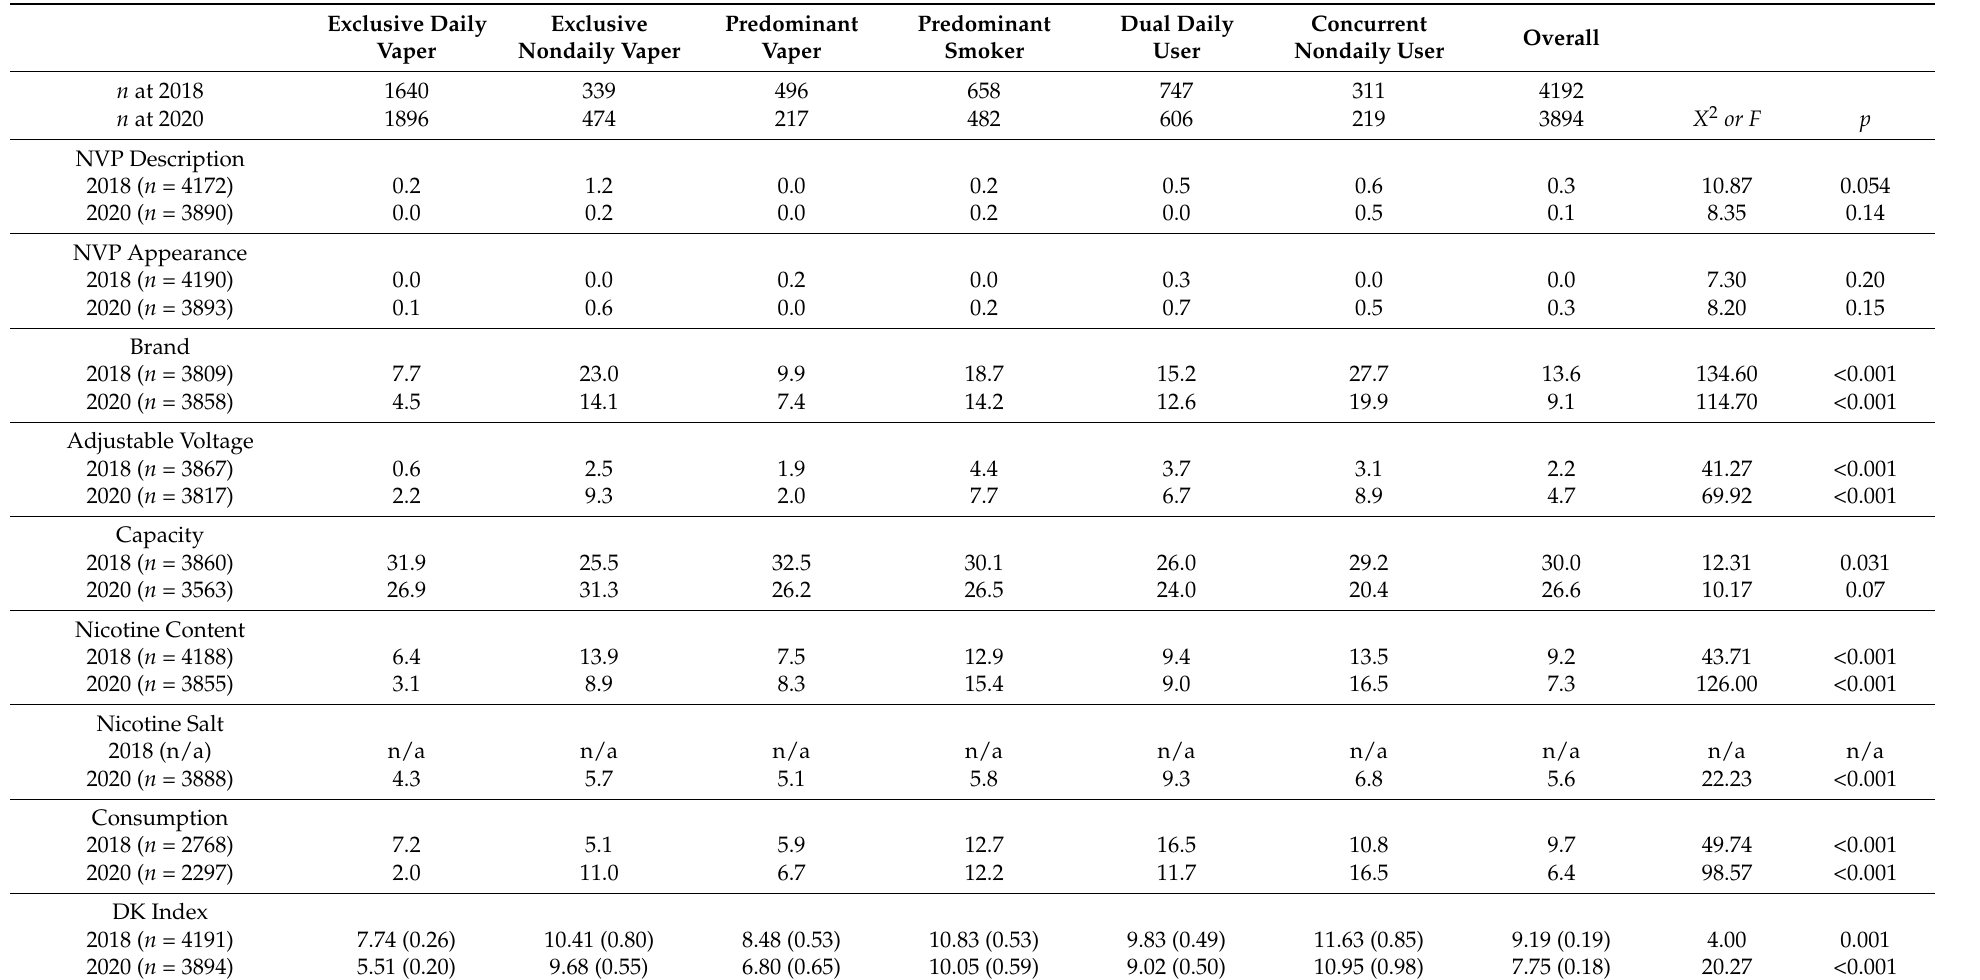
Table 1. DK percentages overall and by vaping/smoking